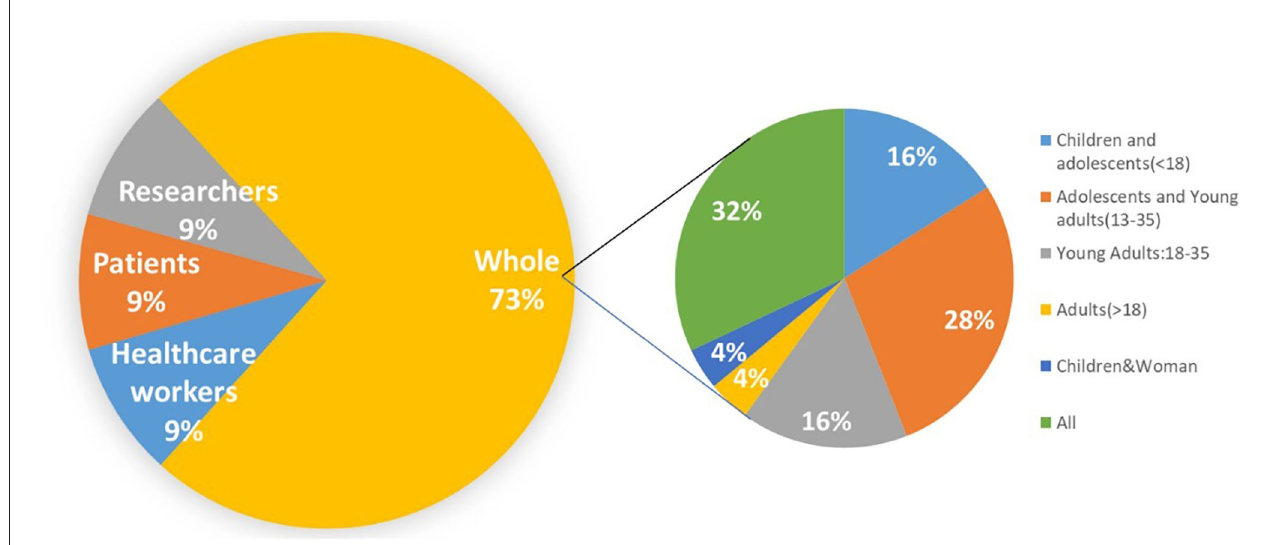
FIGURE 8 | Pie chart showing targeted groups in healthier population studies.